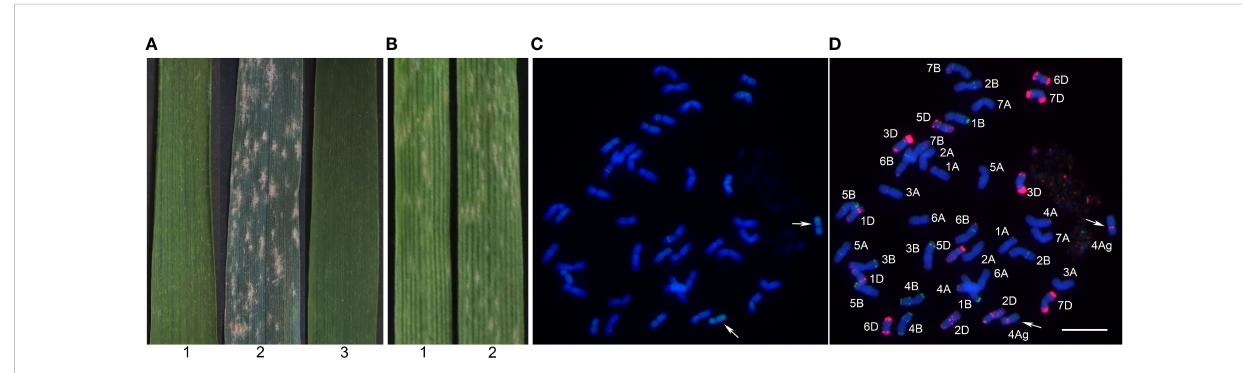
FIGURE 2 The powdery mildew resistance evaluation and cytogenetic analysis. (A) The powdery mildew resistance evaluation at the adult plant stage. (B) The powdery mildew resistance evaluation at the seedling stage. (C) The GISH pattern of 19ZQ43 probed with total genomic DNA of Th. ponticum . (D) The mc-FISH pattern of 19ZQ43 using probes pAs1 (red) and pSc119.2 (green). 1: Blue 58; 2: Xiaoyan 81; 3: 19ZQ43. The arrows note a pair of 4Ag chromosomes. Bar = 20 m